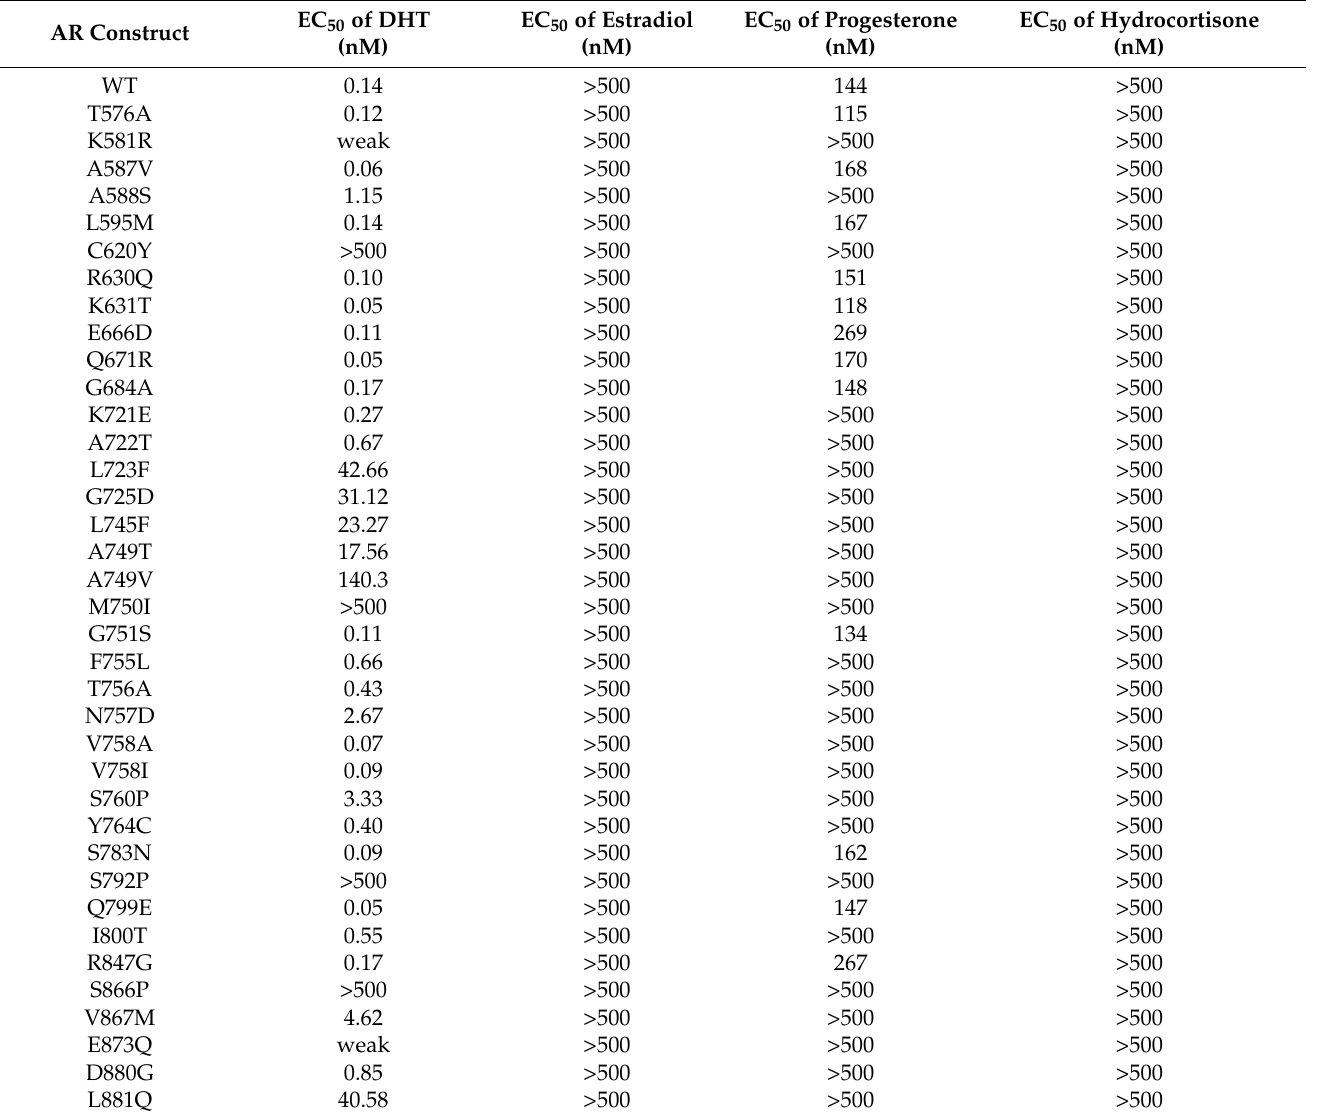
Table S2). Twelve mutants (T576A, A587V, L595M, K721E, G751S, V758A/I, Y764C, S783N, Q799E, D891N and Q903R) with similar or higher affinities than WT were over-stimulated and reached higher levels of transcriptional activation up to 2 times more than WT (Figure 2A and Table S2). Another set of mutants (L723F, G725D, L745F, N757D, S760P, V867M and L881Q) were stimulated by higher concentrations of DHT with EC50s ranging from three to ~40 nM; however, they reached higher levels of activity. One such example is L723F (EC50 = 43 nM), showing 2.5-fold increased activity compared to the wild-type AR (Figure 2B and Table S2). These new results illustrate the very heterogeneous response of AR mutants to DHT, ranging from complete insensitivity to hyper-activation. Table 1. The activation of AR mutants by various steroids. The EC50 values of the activation by DHT, estradiol, progesterone and hydrocortisone are reported for the wild-type AR and the 44 studied mutants. For steroid activation, we tested a concentration range up to 500 nM; therefore, mutants showing no activation or very weak activation in the studied range are presented with EC50 values > 500